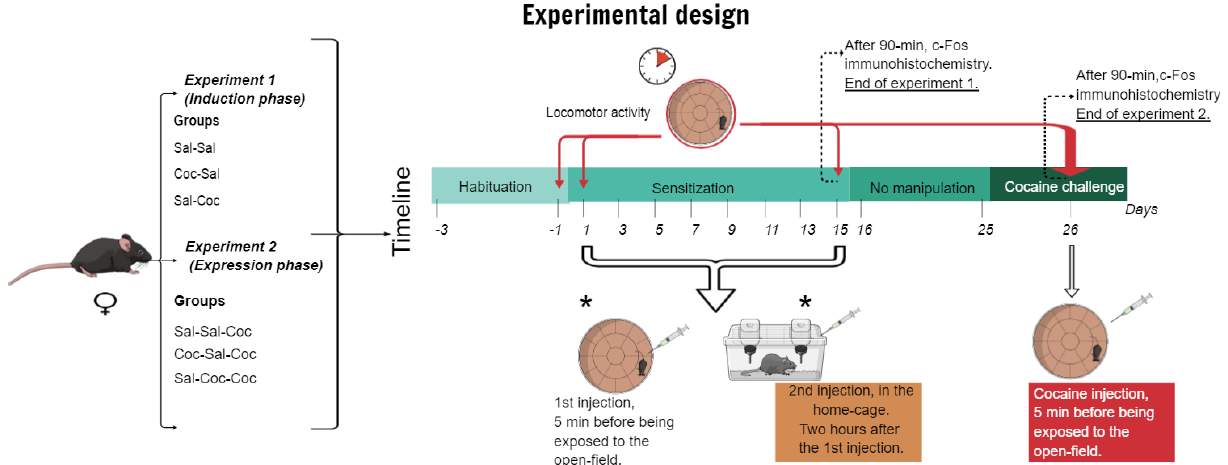
Figure 1. Experimental designs of the induction (experiment 1) and expression (experiment 2) phase of cocaine-induced hyperlocomotion with a timeline. Groups were distributed according to the experiment. (*) Represents that the first and second injection during the sensitization period was administered concerning the group treatment. Both injections were applied on the same day. During the sensitization period, the injections were applied on the odd days (1, 3, 5, 7, 9, 11, 13, and 15). The first injection was applied in the open-field and two hours later in the animal´s home-cage. On the even days (2, 4, 6, 8, 10, 12, and 14), animals were not handled.